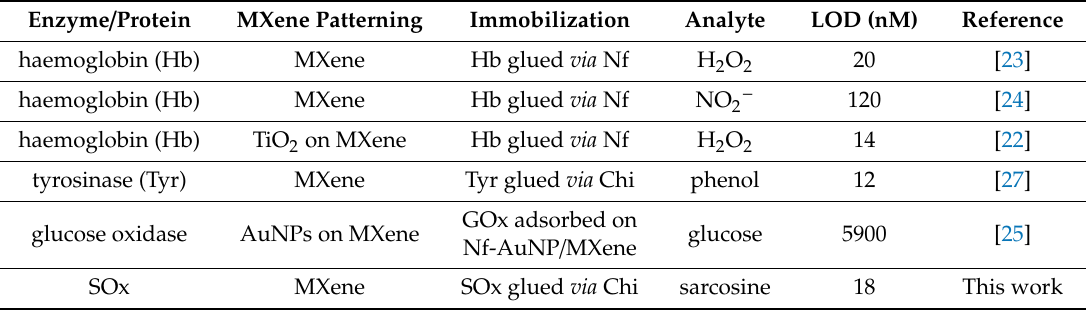
Table 1. Electrochemical biosensors based on MXene with integration of redox proteins /